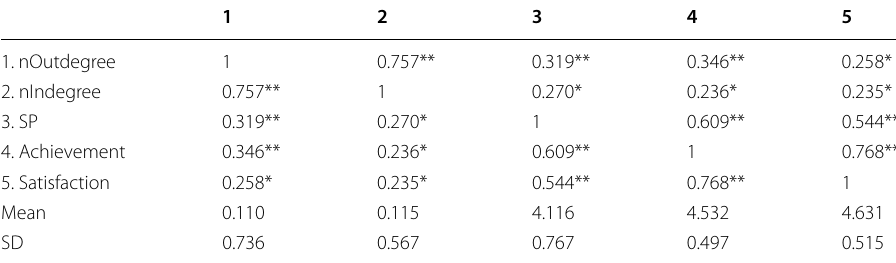
Table 5 Descriptive statistics and Spearman’s